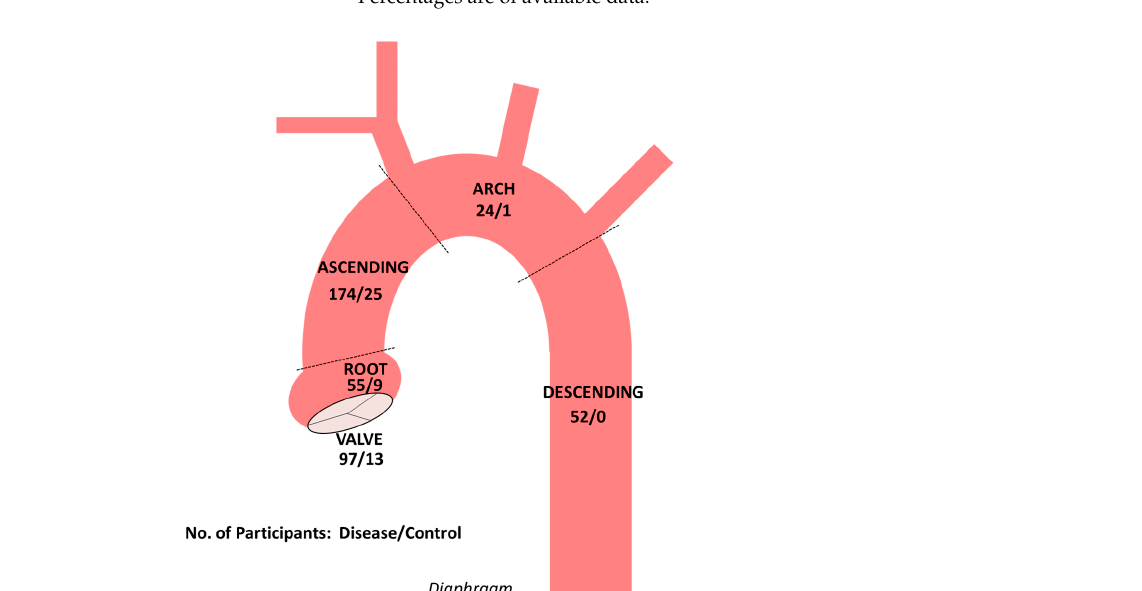
Figure 2. Numbers of aortic and aortic valve tissue samples collected to date in participants with aortopathy or aortic valve disease and normal controls. Dashed lines demarcate the boundaries of thoracic aortic segments.